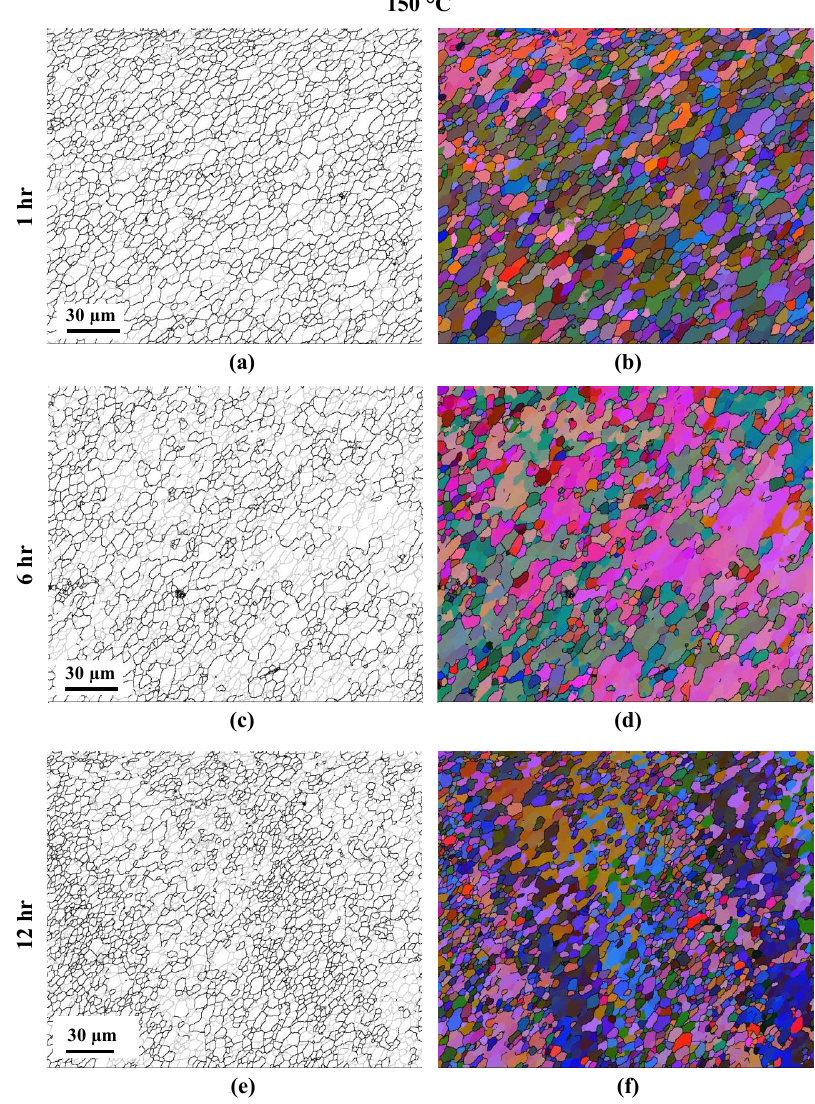
Figure 5. EBSD Grain boundary reconstruction maps and corresponding Euler maps of FSP AA6082 artificially aged at 150 °C for: ( a , b ) 1 h; ( c , d ) 6 h; ( e , f ) 12 h.